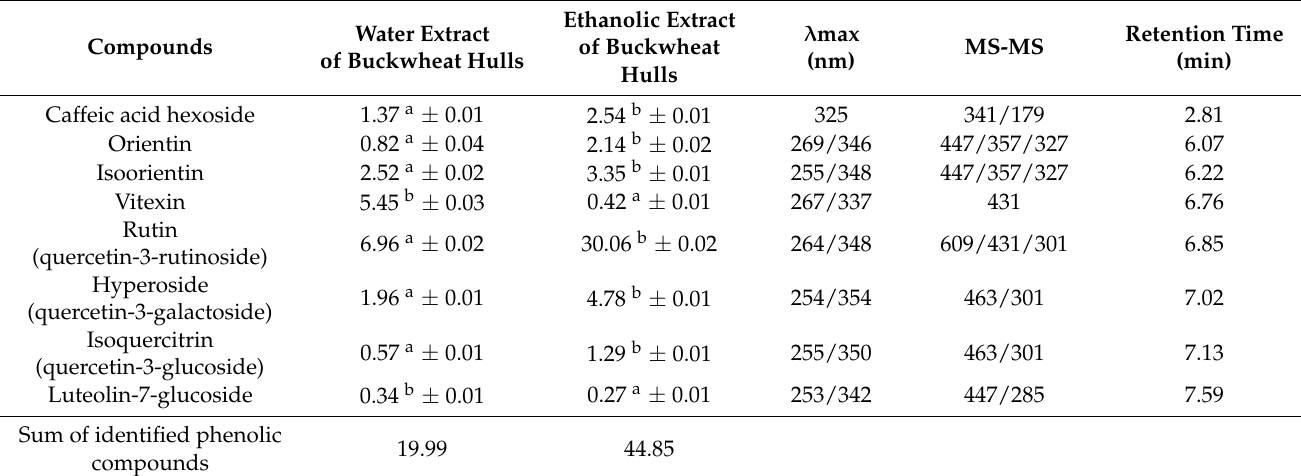
Table 1. Phenolic compounds (mg/g dm ) in buckwheat hull